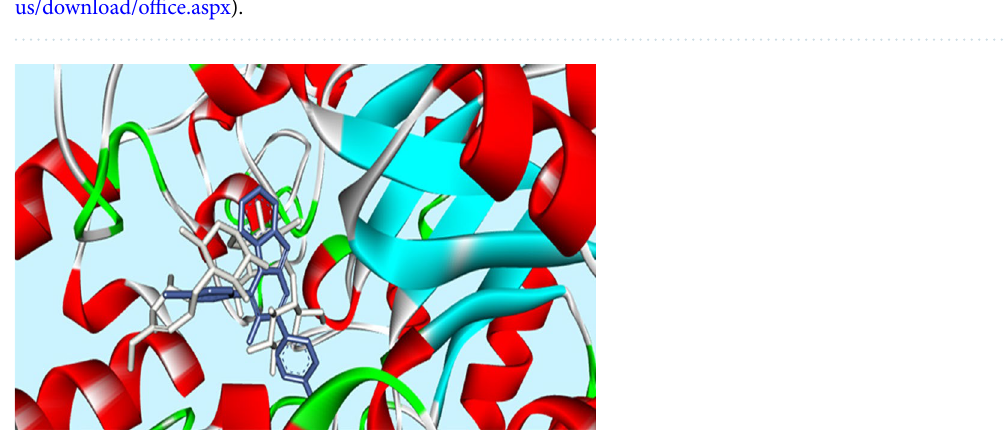
Figure 3. Acarbose (gray) and most potent compound 3k (blue) superimposed in the active site pocket. *This figure was created by using Discovery Studio 4.0 Client (https:// disco ver. 3ds. com/ disco very- studio- visua lizer- downl oad) and LigPlot (https:// www. ebi. ac. uk/ thorn ton- srv/ softw are/ LigPl us/ downl oad.